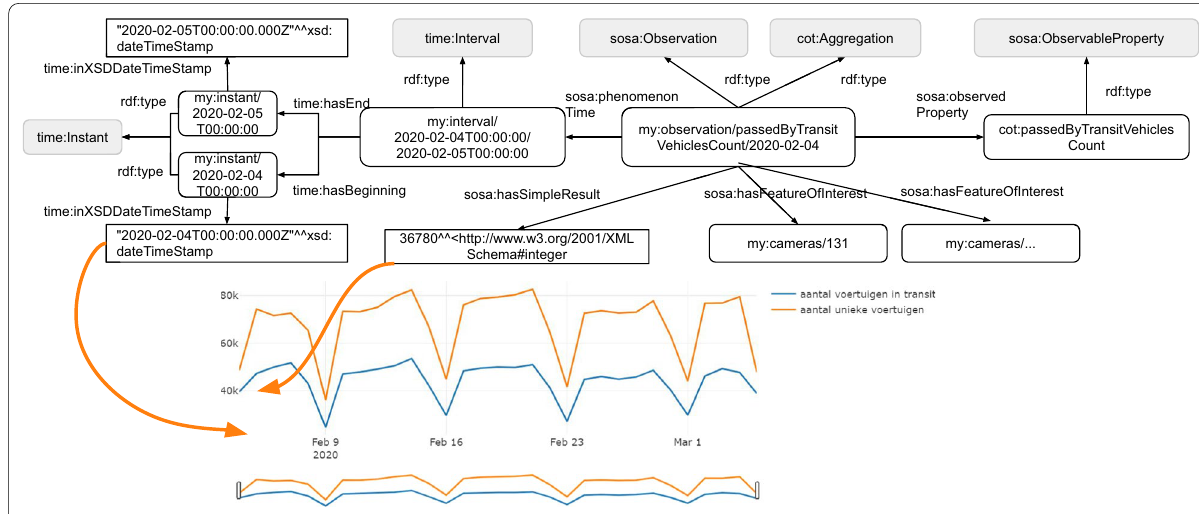
Fig. 9 Unique versus in transit vehicles visualization. More than half of the detected vehicles are in